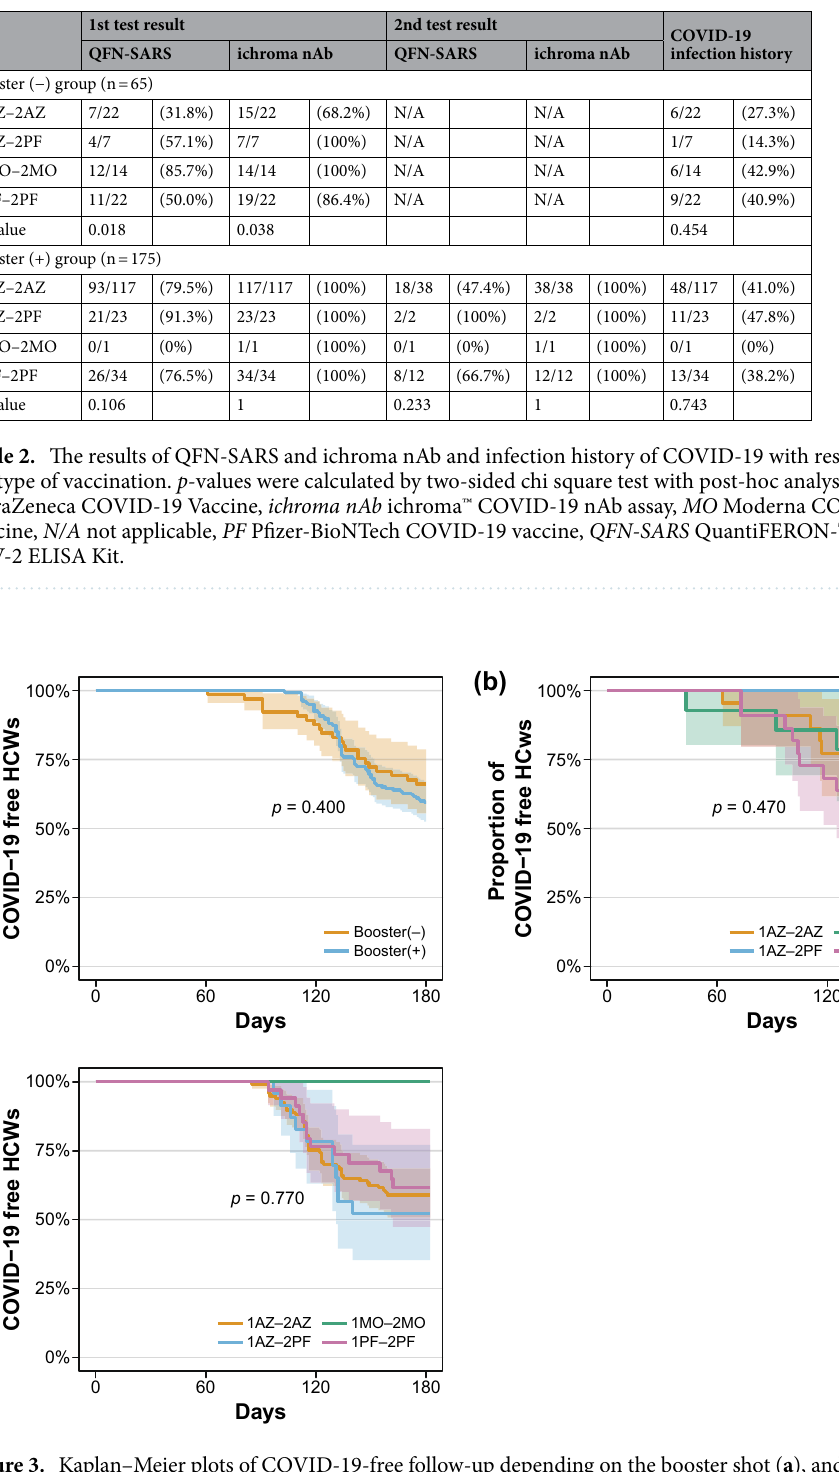
Figure 3. Kaplan–Meier plots of COVID-19-free follow-up depending on the booster shot ( a ), and the type of SARS-CoV-2 vaccination for booster (−) group ( b ) and booster (+) group ( c